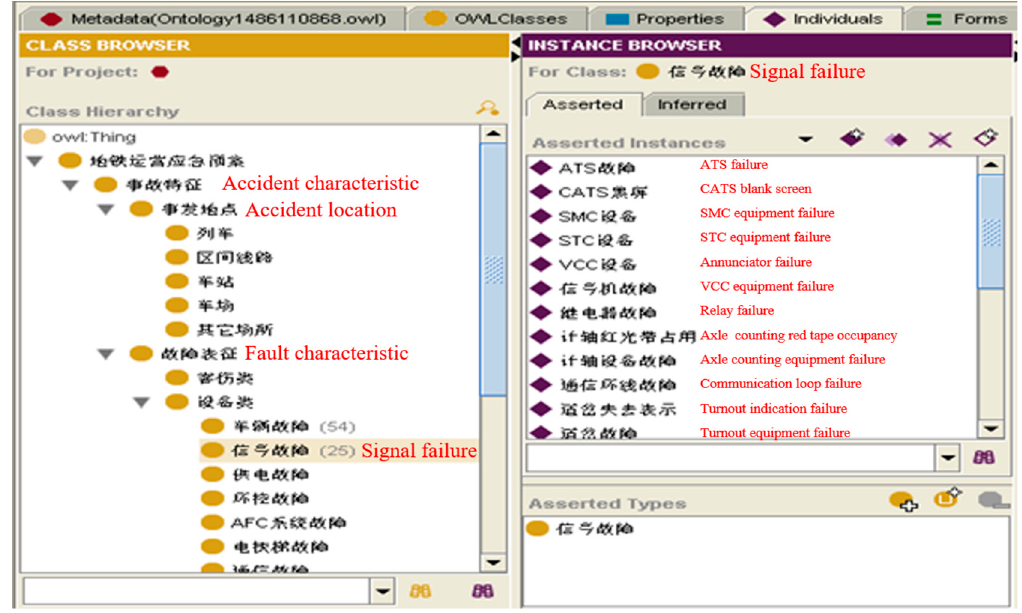
Figure 7. The screenshot of classes and individuals of the “signal system failure.”